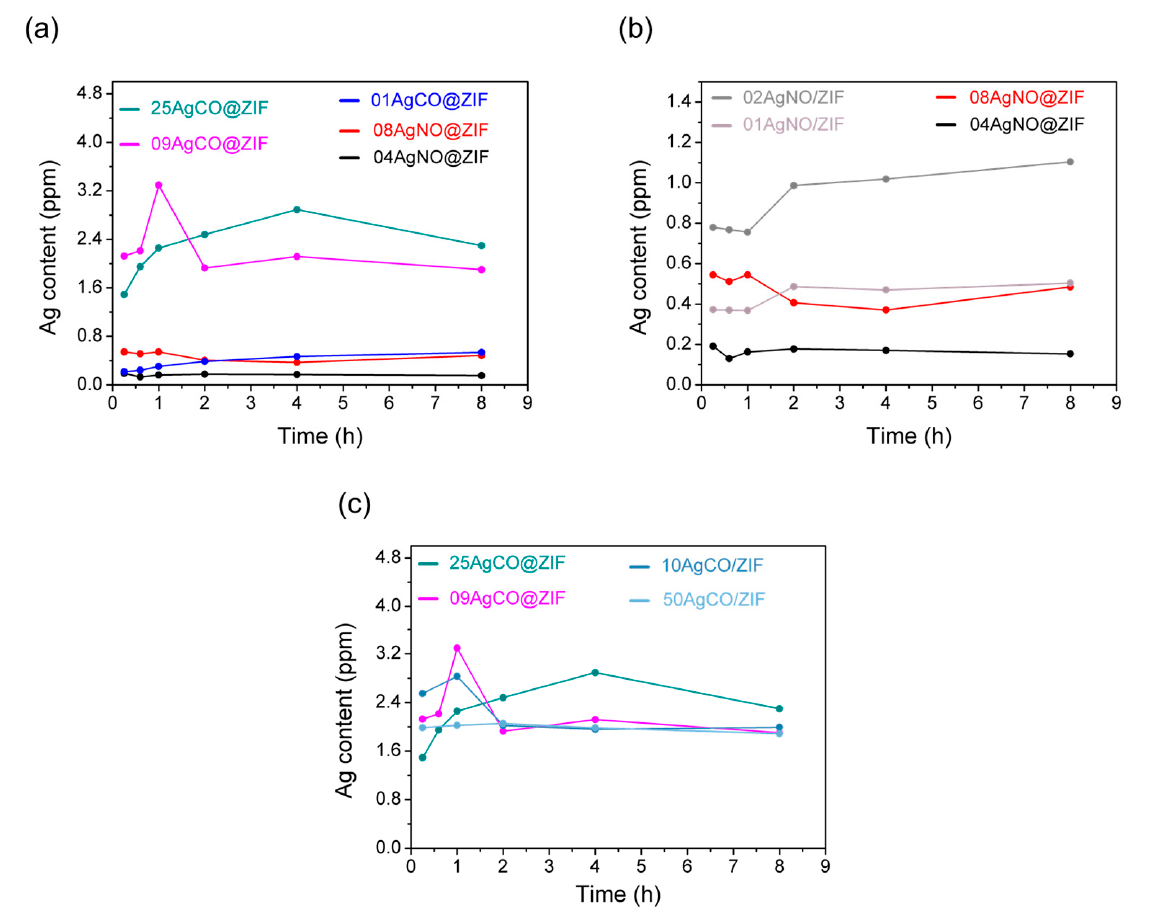
Figure 10. The silver release behavior of ( a ) using AgNO 3 and Ag 2 CO 3 precursors with de novo method, ( b ) using AgNO 3 precursor with de novo and impregnation methods, ( c ) using Ag 2 CO 3 precursor with de novo and impregnation methods.